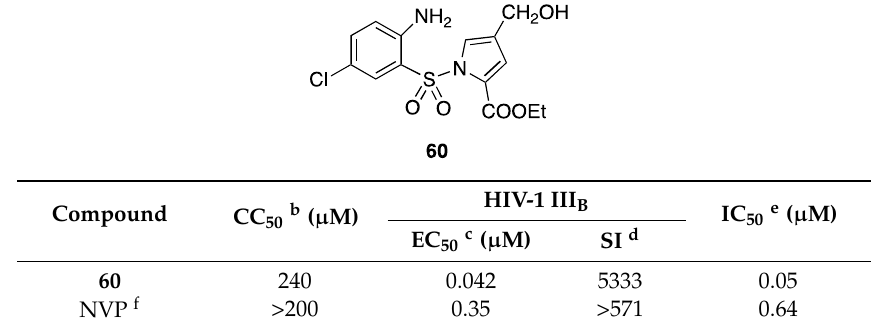
Table 7. Anti-HIV-1 activity of PAS 60 in MT-4 cells and against rRT a .